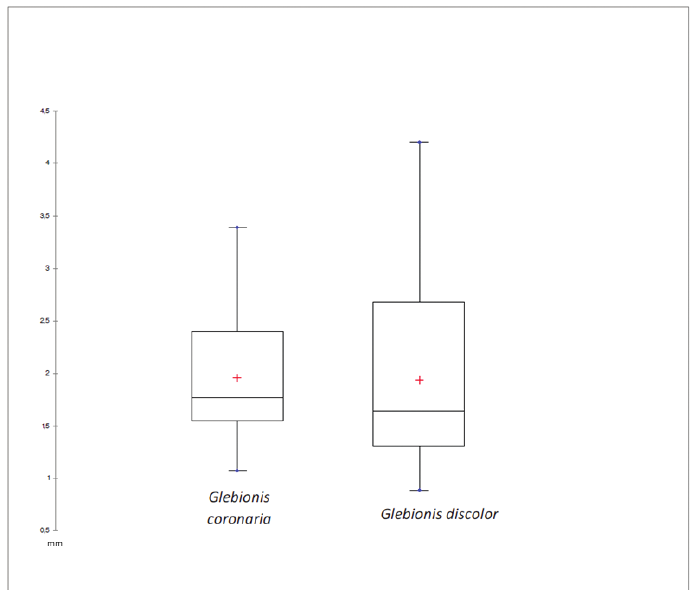
Figure 6. Statistical analysis by box plot of disc cypselas width of Glebionis coronaria and G. discolor .